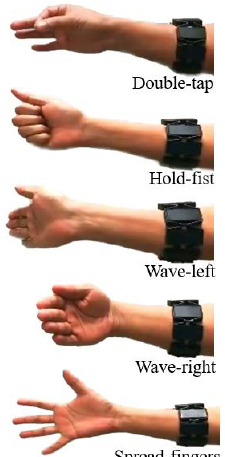
Figure 7. Example of hand movements.